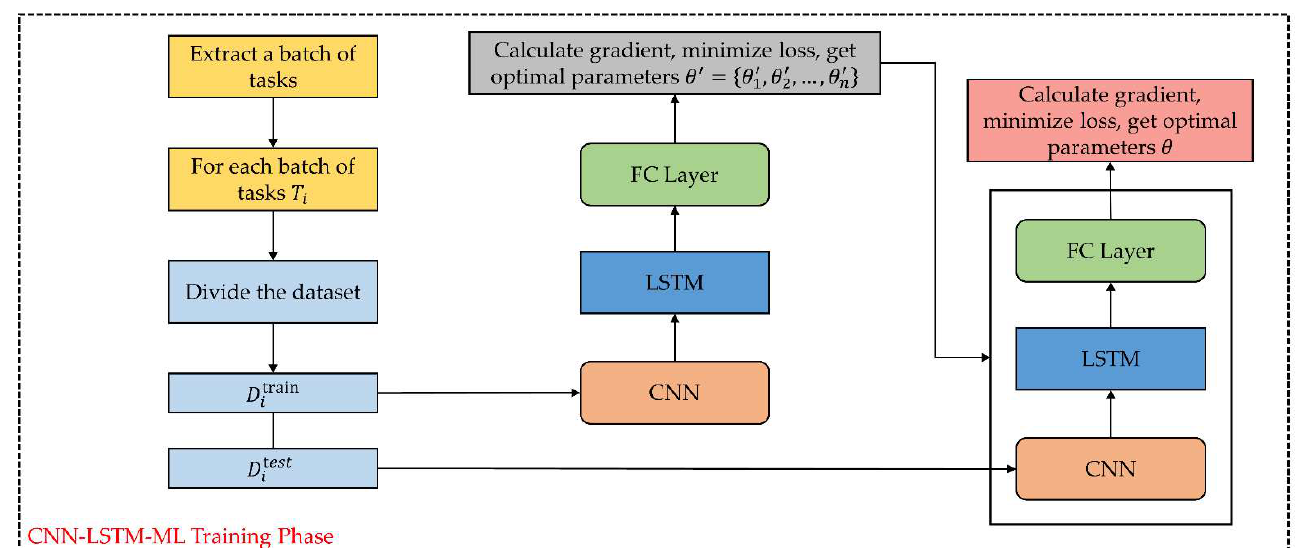
Figure 6. The internal structure of CNN-LSTM-ML.